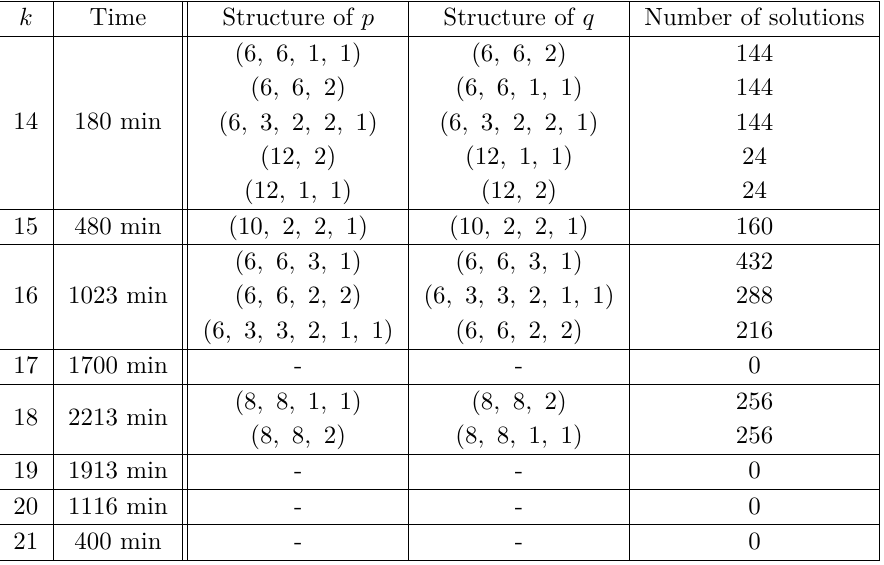
Table 2: Results for optimal permutations with DR max ( π ) =